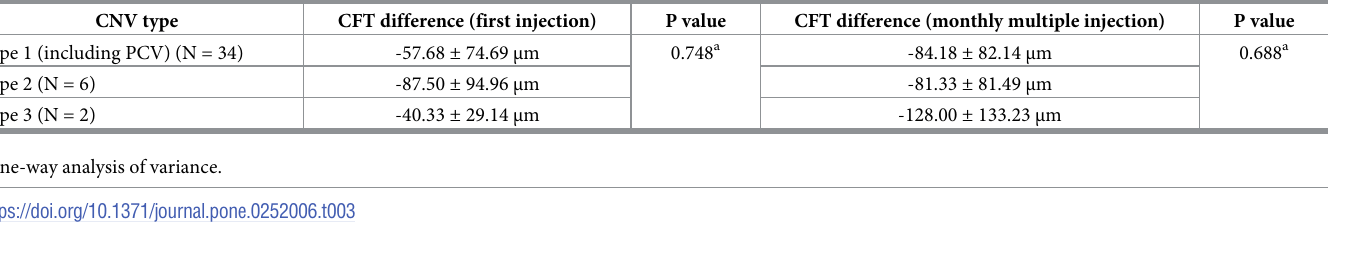
Table 3. Central foveal thickness (CFT) difference by choroidal neovascularization (CNV) type. CNV